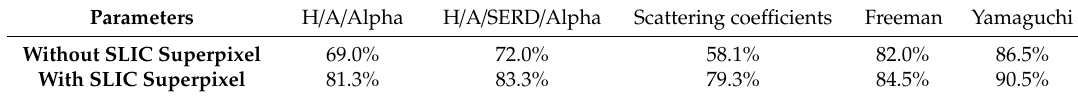
Table 6. Total MIoU results of each group of polarimetric parameters.